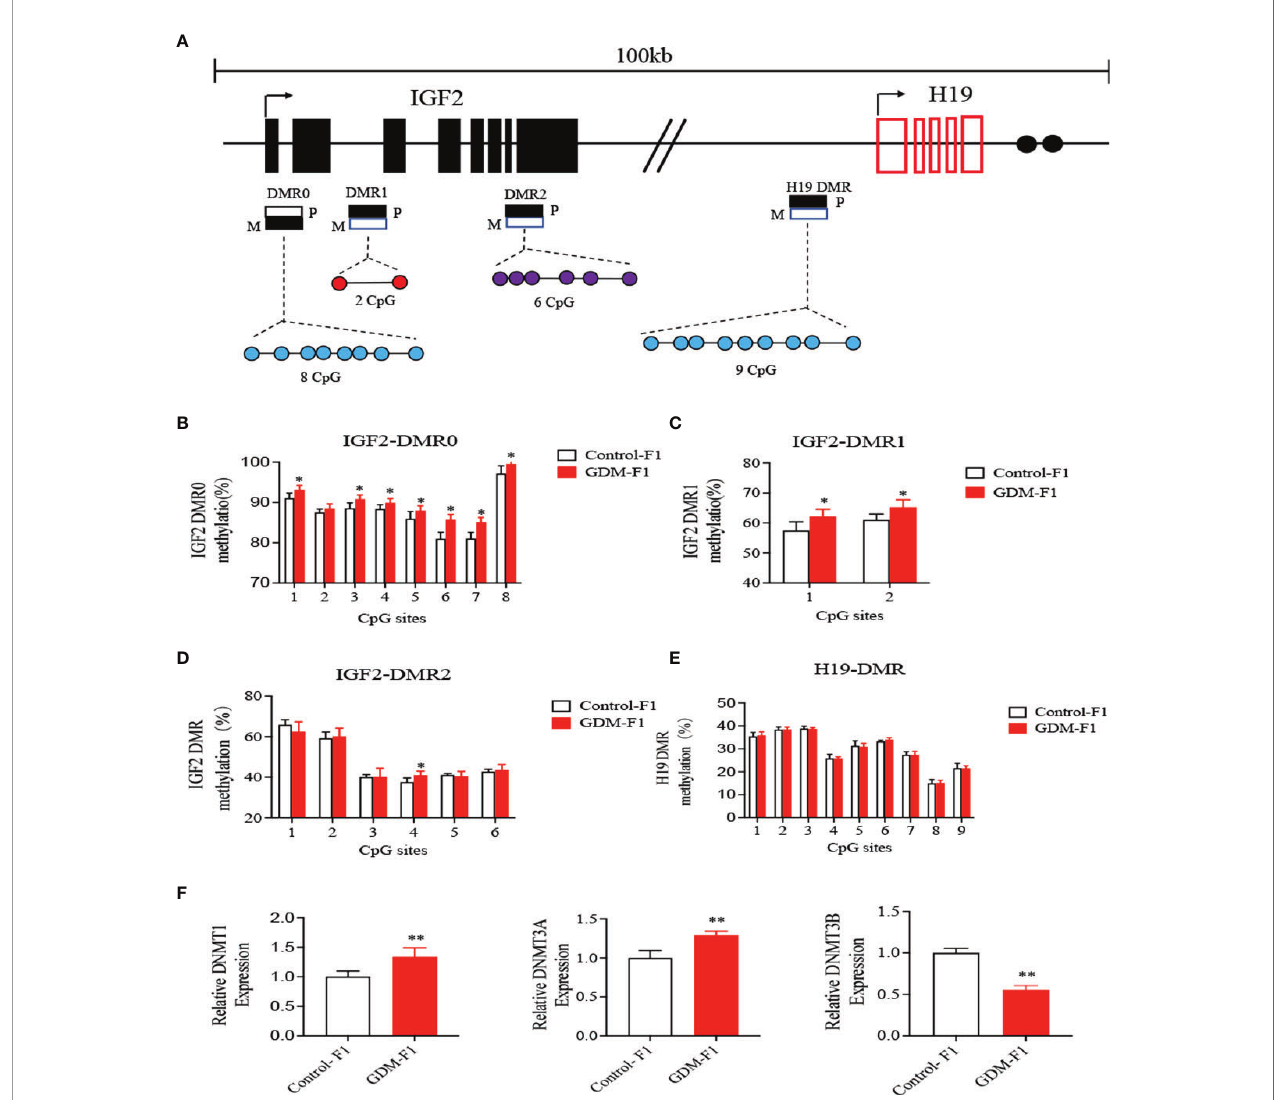
FIGURE 4 | Methylation analysis of IGF2/H19 DMRs by pyrosequencing. (A) Schematic representation of mouse imprinted locus, showing the relative positions of the IGF2 and H19 genes and indicating the location of the four DMR knows to contribute to IGF2 imprinting. Enhancers (E) are indicated as black circles. The locations of the four DMRs within the IGF2/H19 imprinted locus represented by boxes are shaded to indicate preferential methylation of the maternal (M) or paternal (P) allel in each region. (B – E) Percentage of methylation for each CpG cytosine is calculated. (B) Methylation status of individual DNA strands of IGF2-DMR0 containing 8 CpG sites; (C) IGF2-DMRI containing 2 CpG sites; (D) IGF2-DMR2 containing 6 CpG sites; (E) H19-DMR containing 9 CpG and the average methylation ratio in each CpG site. (F) The relative gene expression of DNMTI, DNMT3A, DNMT3B in the liver of 8-week-old mice. Data were analyzed with the Eq. 2 - DD CT , where DD CT = D CT (treatment group) - D CT (control group), and D CT = D CT (sample) - D CT (internal control). The values were normalized to ACTIN mRNA levels. For pyrosequencing and RT-qPCR, every group contains 10 mice. In all panels, data are presented as mean ± SD, * P < 0.05, ** P < 0.01, Signi fi cance was determined by Student t